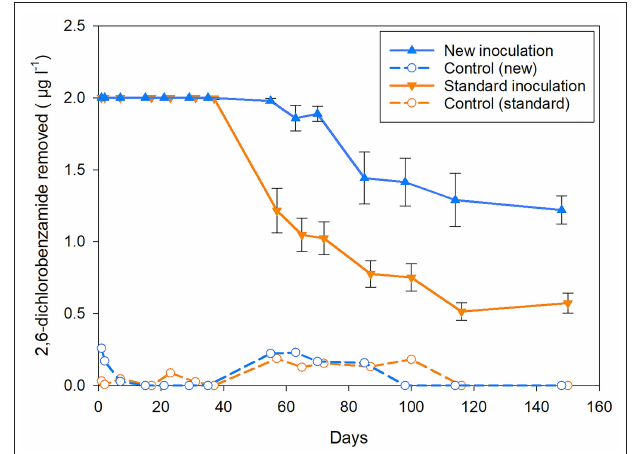
FIGURE 2 | Amount of 2,6-dichlorobenzamide (BAM) removed in the columns comparing the new (blue) or the standard (orange) inoculation strategy. Triangles represent columns inoculated with BAM-degrader Aminobacter sp. MSH1, while circles represent control columns. All columns received tap water spiked with BAM to a final concentration of 2 µ g l − 1